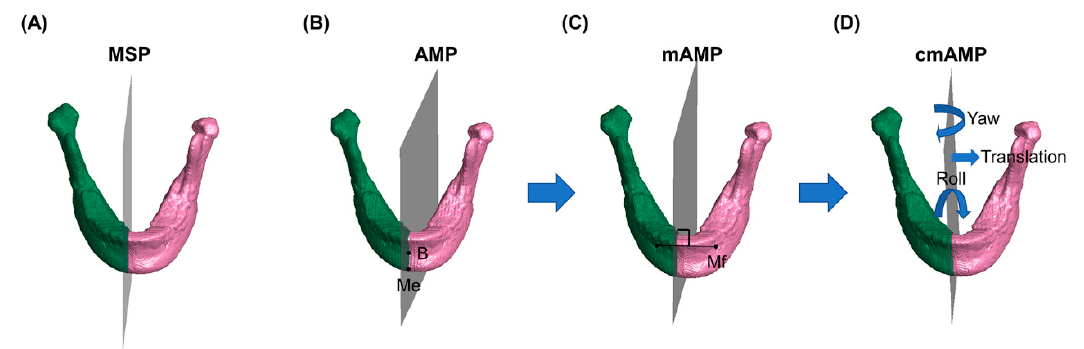
Figure 1. Setting up each mandibular midsagittal plane: ( A ) facial midsagittal plane (MSP); ( B ) absolute mandibular midsagittal plane (AMP); ( C ) modified absolute mandibular midsagittal plane (mAMP); ( D ) computed modified absolute mandibular midsagittal plane (cmAMP). Me, menton; B, supramentale; Mf, mental foramen.